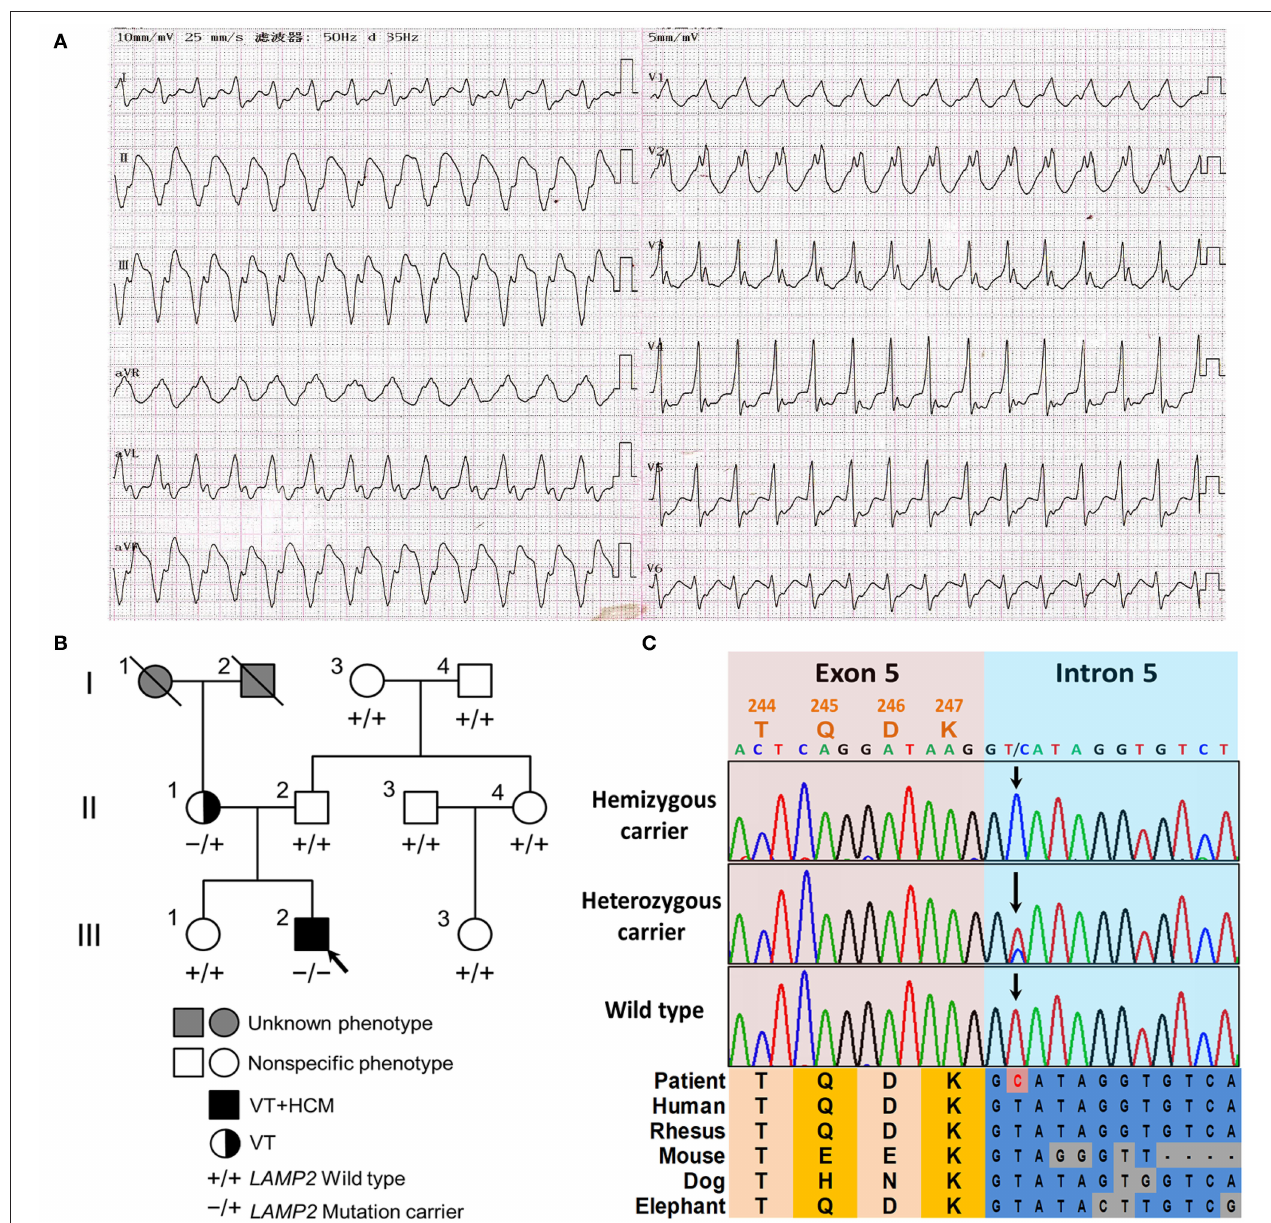
FIGURE 1 | The clinical and genetic characteristics of the pedigree. (A) The 12-lead electrocardiogram (ECG) of the proband revealed ventricular tachycardia and intraventricular block. (B) The family tree of the cardiac-only DD pedigree is included in this report. Male and female are indicated by squares and circles, respectively. The black filled symbol represents the clinical affected individual. The gray-filled symbol represents the phenotype unknown individual. The arrow shows the proband. –/ + represents heterozygous LAMP2 c.741 + 2T > C variant. –/– represents hemizygous LAMP2 c.741 + 2T > C variant. + / + represents a wild type. (C) The Sanger sequencing of the family. Colored blocks show the evolutionary conservation of the cluster across multiple species.